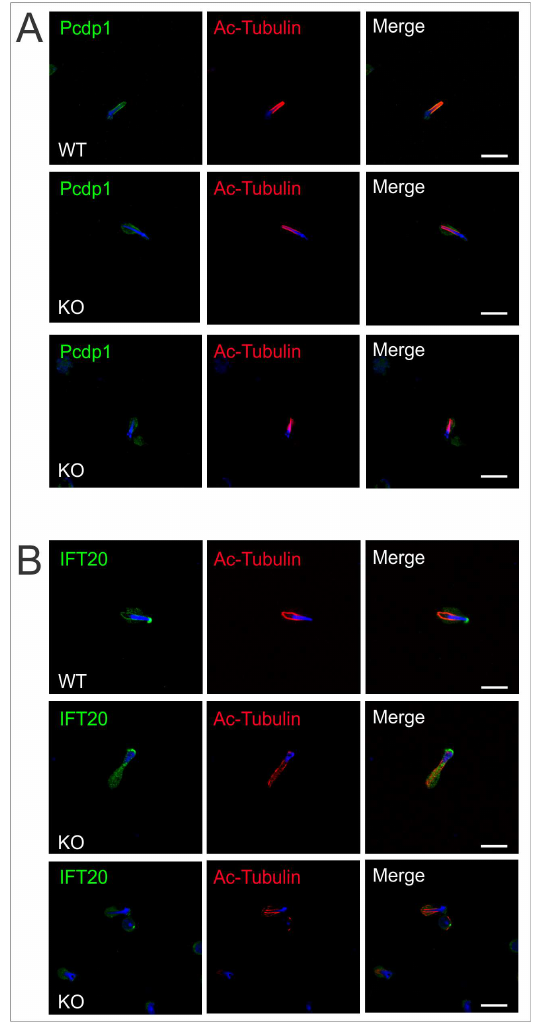
Figure 8 Figure 8. Pcdp1 and IFT20 localization in the manchette is dependent on SPAG17. Germ cells from wild-type and knockout mice were collected from adult mice and stained for proteins associated to manchette structures. ( A ) Pcdp1 and ( B ) IFT20 failed to localize to the manchette in the elongating spermatids from Spag17 knockout mice, and their localization appears diffused in the cytoplasm. Scale bar = 10 µ